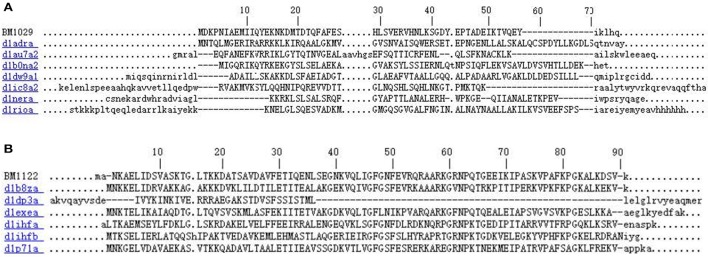
Sequence alignments of BM1029 (A) and BM1122 (B) with DNA-binding domain subfamily proteins by InterPro.